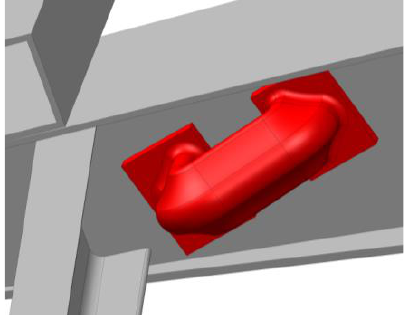
Figure 19. Placement of the unit on the beam bolster of the wagon.